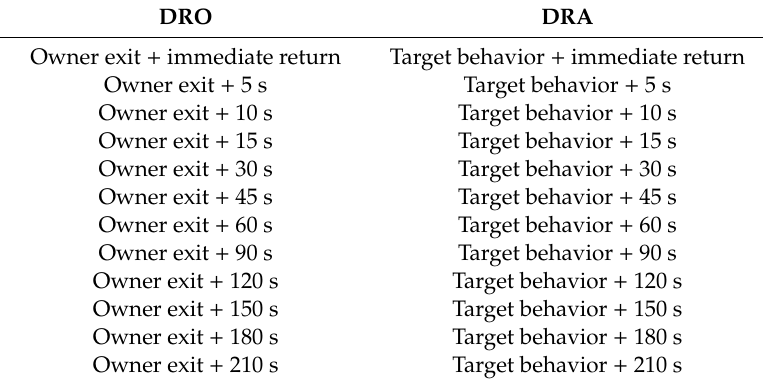
Table 5. Behavioral criteria during treatment. Criteria changes for dogs in the DRO or DRA. Moving to the next criteria required two successful trials without problem behavior at the previous level. If problem behavior occurred on one trial, the criteria returned to the last successful criteria. For Sadie and Tristan, initial DRO criteria varied until the owner could successfully exit the house without the dog exhibiting PB, after which they followed the DRO